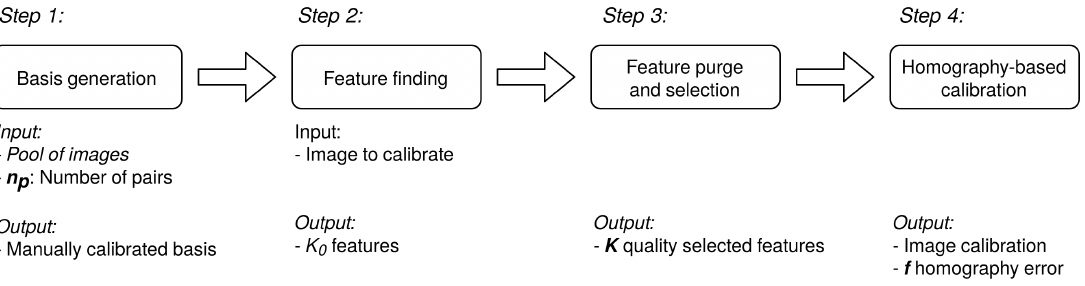
Figure 3. Diagram of the automatic calibration procedure. Table 1. Summary of the parameters in the automatic